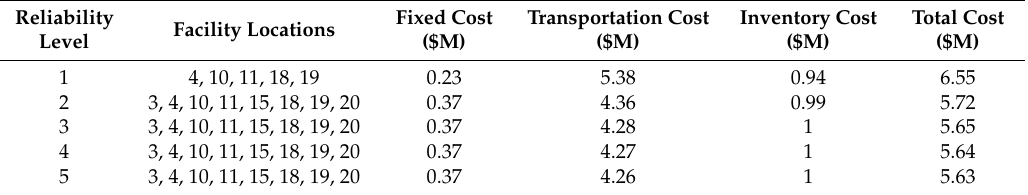
Table 4. Cost with different reliability level in